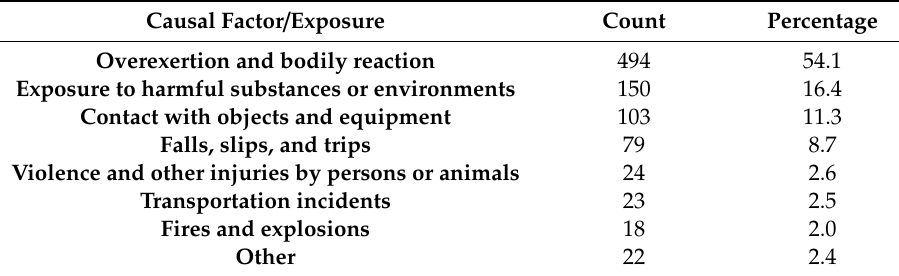
Table 2. Reported causal factor / exposure resulting in injury.